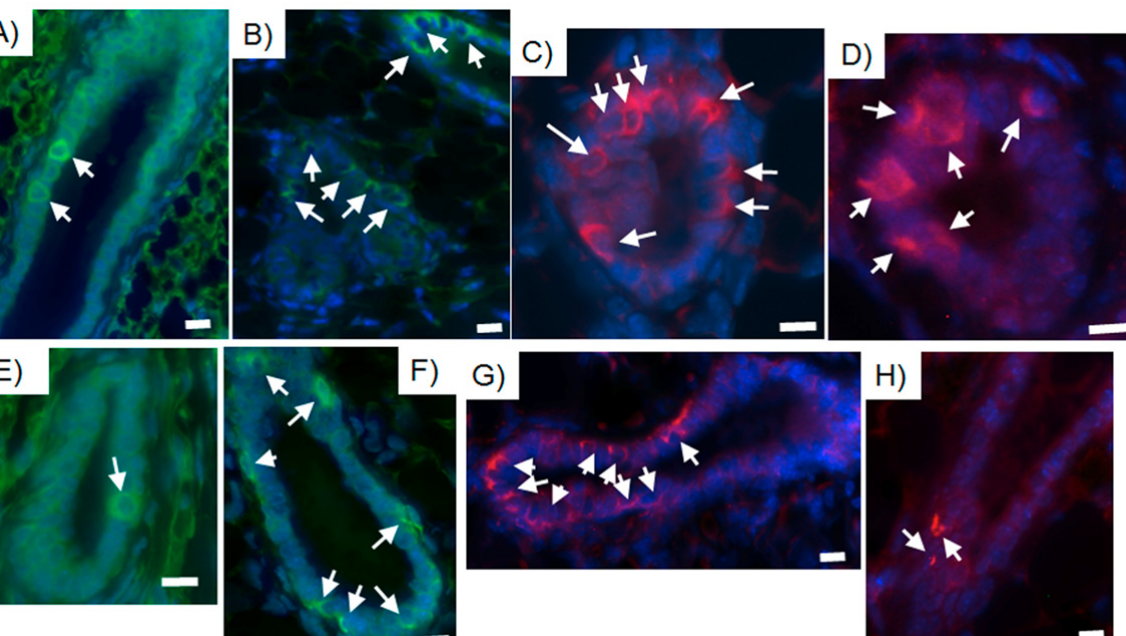
Figure 4. CD44 enriched as well as CD44 depleted human breast cancer cell population are able to integrate and contribute their progeny to chimeric mammary